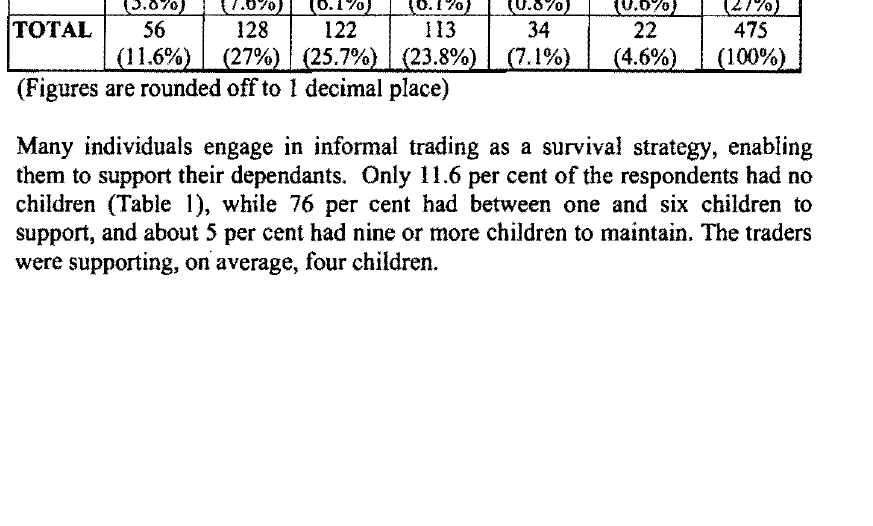
Street traders and number of